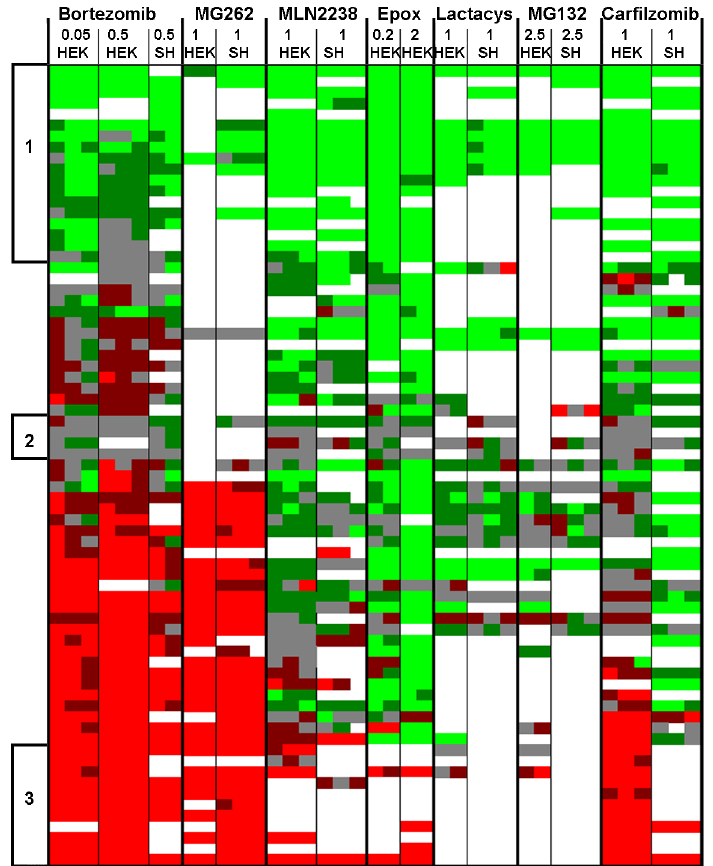
Figure 5. Heat map analysis of selected peptides. Peptides observed in multiple experiments were chosen for this analysis. Different peptides are plotted as separate rows; each column indicates a different experiment and each sub-column represents peptide levels in the biological replicates within that experiment. Ratios of peptides found in multiple charged states were averaged together. White panels could not be accurately quantified, either due to undetectable signals or peak overlap with another co-eluting peptide. Data from the AM114 experiment was not included in the heat map since levels of most peptides were not affected by AM114. Peptide levels were color coded. Bright green indicates peptides that were present in the treated cells at levels # 50% of those in the control cells (ratio # 0.50). Dark green indicates peptides that showed a smaller decrease (ratio 0.51– 0.80). Grey indicates peptides that were close to the levels in the control cells (ratio 0.81–1.24). Dark red indicates peptides that were elevated 25– 99% (ratio 1.25–1.99). Bright red indicates peptides that were elevated $ 100% (ratio $ 2.00). The three groups in the heat map indicated by lines and numbers on the left margin indicate peptides which showed a large or partial decrease (set 1), little or no change (set 2), or a large increase (set 3) in response to the proteasome inhibitors. See Table S2 for an expanded version of this figure, including peptide sequences and ratio